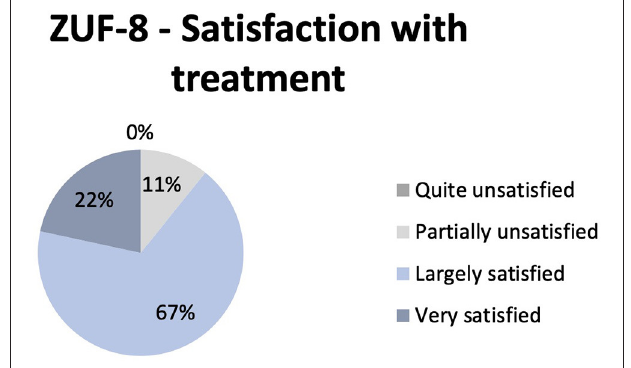
FIGURE 3 | Reported satisfaction with NIPA treatment as measured by Patient Satisfaction Questionnaire (ZUF-8). Diagram shows the frequency of the different levels of